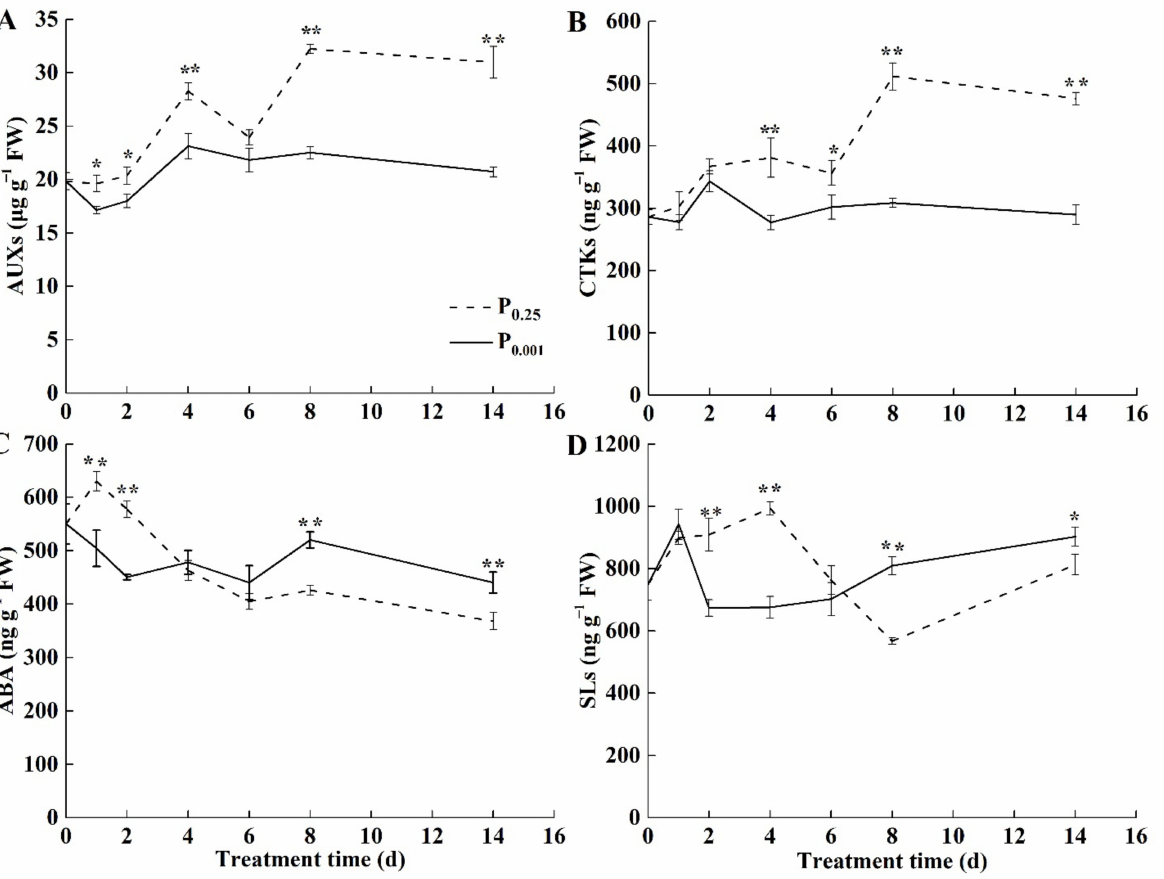
Figure 3. Changes in the endogenous hormone contents ( A ) AUX, ( B ) CTK, ( C ) ABA, and ( D ) SL in melon leaves. The error bars indicate SD ( n = 4). The asterisks indicate the significant differences according to Tukey’s test using a one-way ANOVA (* p < 0.05; ** p <